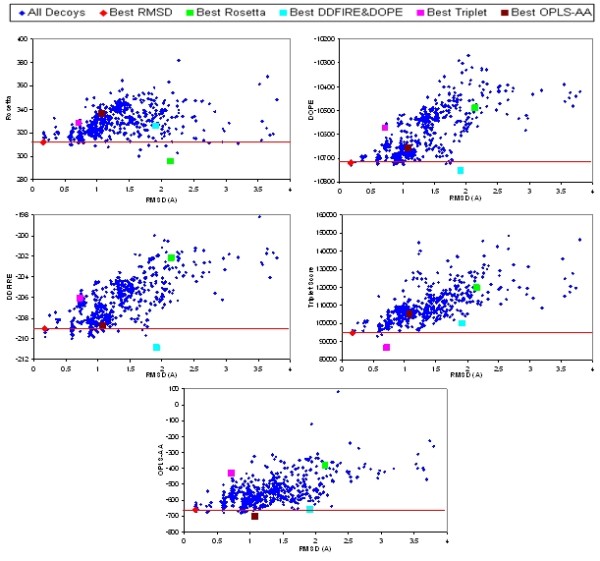
RMSD-Score Plot of 1onc(70:78) Decoy Set in Various Scoring Functions